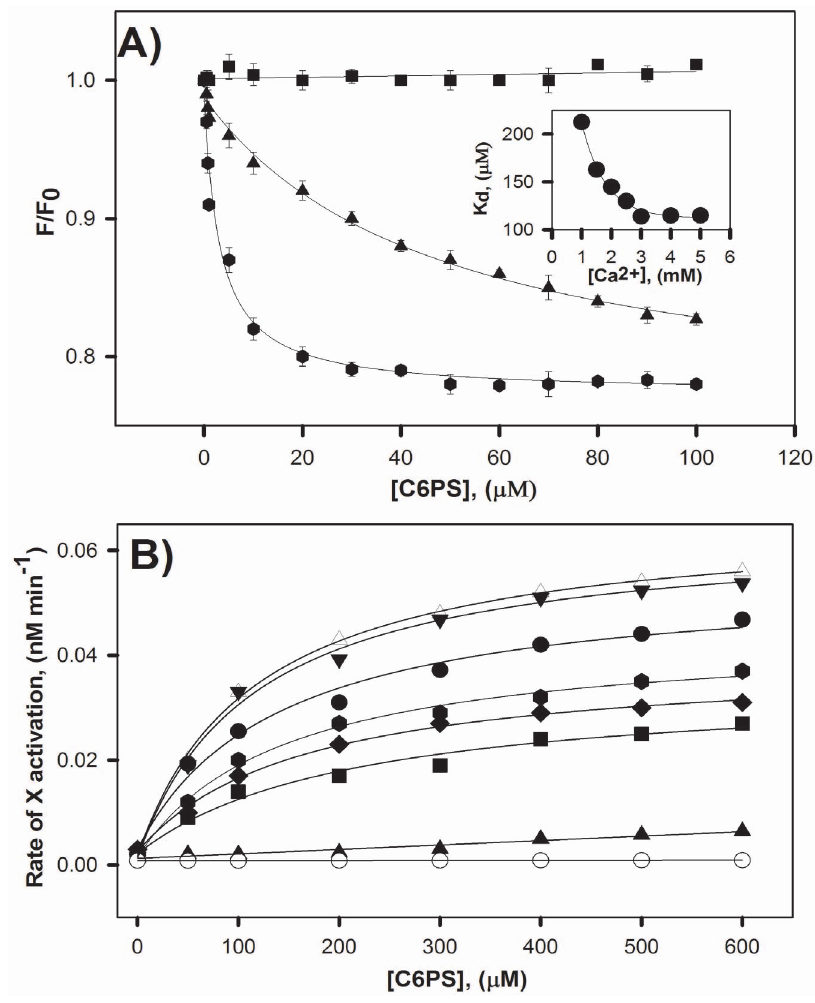
Figure 4. Effect of Ca 2 + on the intrinsic fluorescence and proteolytic activity of FIXa in the presence of C6PS. A. The response of integrated intrinsic fluorescence to added C6PS is plotted for three different Ca 2 + concentrations: 0 mM Ca 2 + with 1 mM EDTA (squares), 1 mM Ca 2 + (triangles), and 3 mM Ca 2 + (hexagon). Hyperbolic fits of the data gave apparent K d ’s , 47 m M and 3 m M for 1 and 3 mM Ca 2 + , respectively. B. The proteolytic activation of FX by 25 nM FIXa at pH-7.5, was monitored at 0 mM Ca 2 + (with 1 mM EDTA) – open circle, 1 mM Ca 2 + - triangle, 1.5 mM Ca 2 + - square, 2 mM Ca 2 + - diamond, 2.5 mM Ca 2 + - hexagon, 3 mM Ca 2 + -circle, 4 mM Ca 2 + - inverted triangle, and 5 mM Ca 2 + - open triangle. The inset to 4A shows a plot of apparent K d ’s obtained from hyperbolic fits of the activity data as a function of Ca 2 + concentration. The plot shows 3 mM Ca 2 + is sufficient for optimum FX activation by FIXa in the presence of